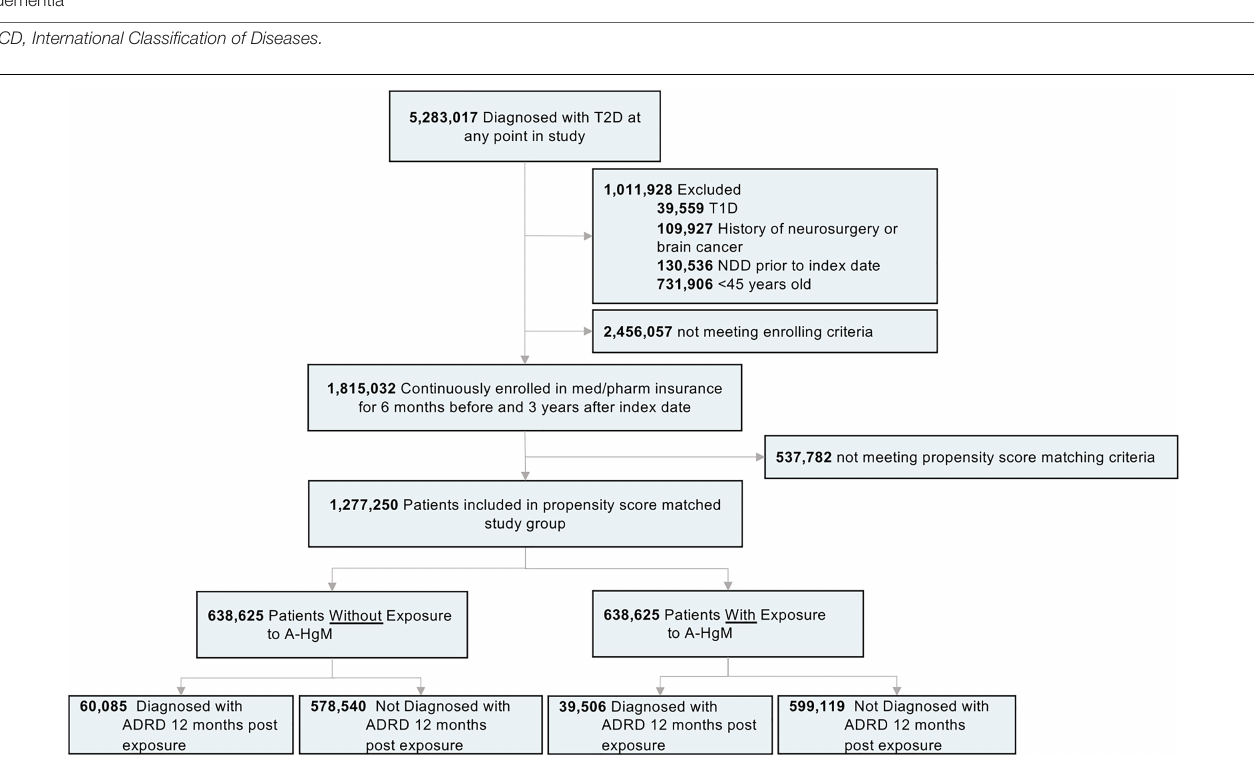
FIGURE 1 | Study design and patient breakdown. T2D, type 2 diabetes; T1D, type 1 diabetes; NDD, neurodegenerative diseases; A-HgM, anti-hyperglycemic medication; ADRD, Alzheimer’s disease related dementias.